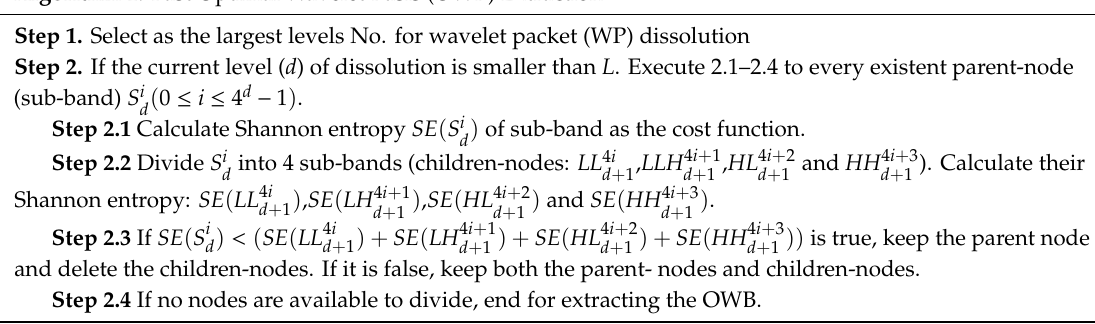
Algorithm 1: Fast Optimal Wavelet Basis (OWB)